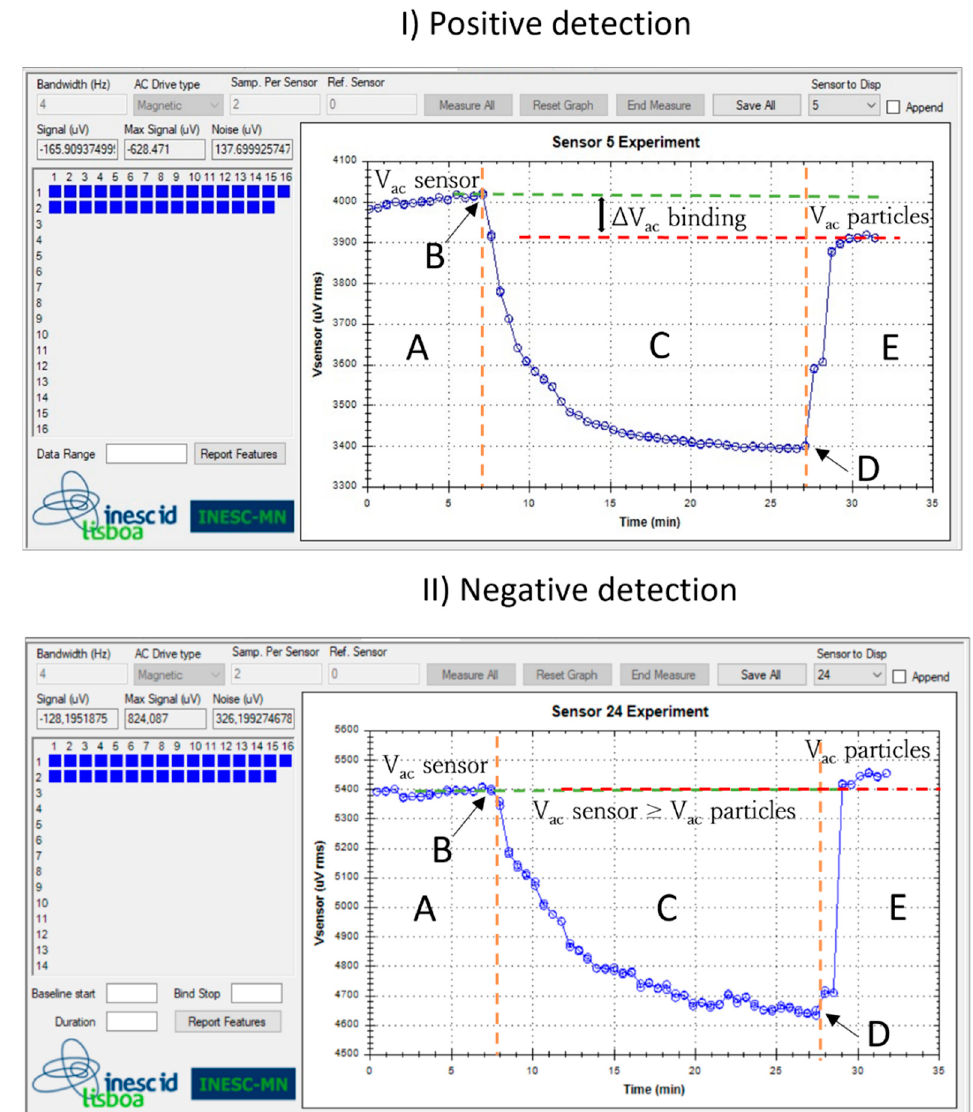
Figure 2. Voltage signal acquired from two sensors. Both measurements occur through five phases: (A) acquisition of the sensor baseline signal (V acsensor ); (B) magnetic particle addition; (C) decreasing signal due to the magnetic particles settling down over the sensor; (D) saturation signal; and (E) washing step and final signal corresponding to the presence of target bound magnetic particles over the sensor (V ac particles ): ( I ) positive detection event: hybridization with a complementary target DNA ( Globodera pallida ) labeled with 250 nm magnetic particles ending at a lower voltage and ( II ) negative detection event: non-hybridization with a non-target DNA ( G. rostochiensis ) ending at an equal voltage value.